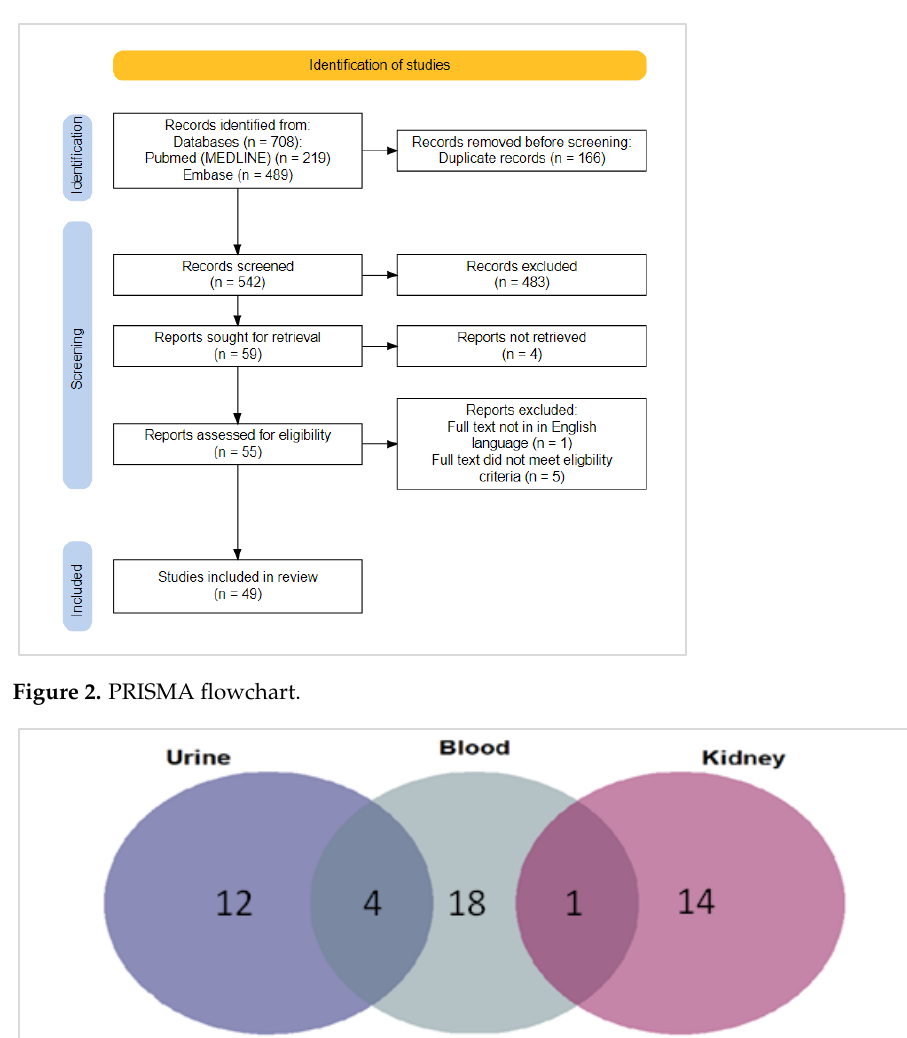
Figure 2. PRISMA flowchart.